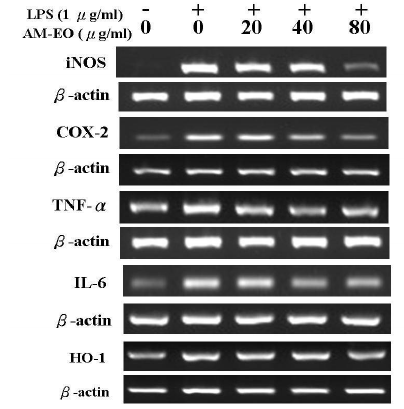
Figure 5. The effect of AM-EO on the mRNA expression levels of iNOS, COX-2, TNF- α , IL-6 and HO-1 in LPS-stimulated RAW 264.7